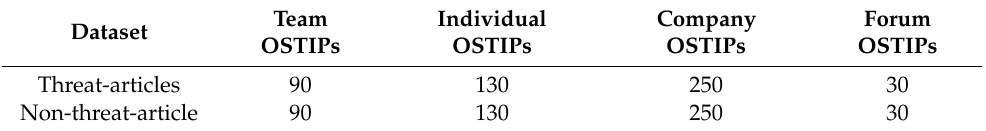
Table 6. Labeled datasets for training article classification model.